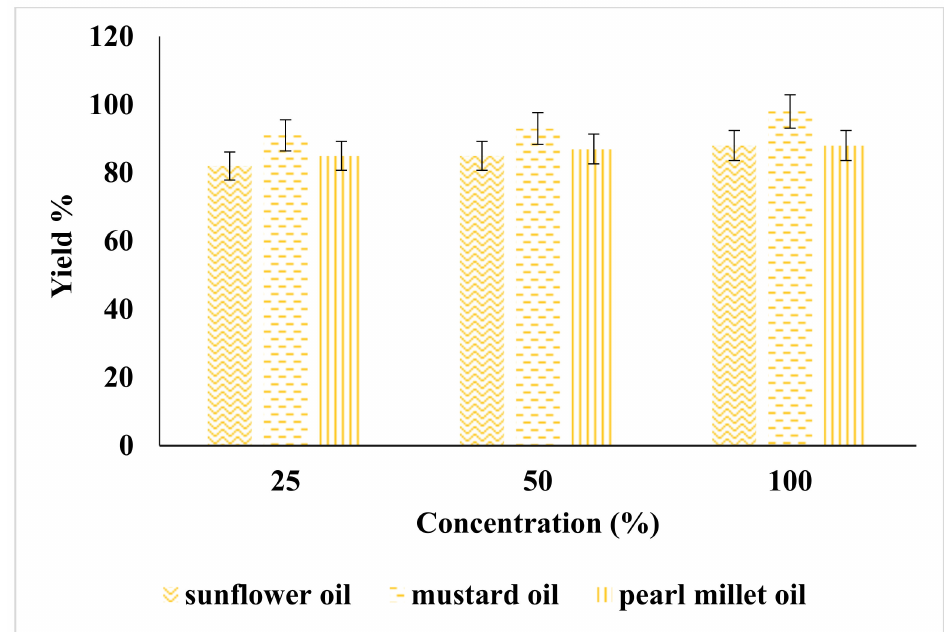
Figure 3. Percentage yield of biodiesel using HCl (wt.%) as acid catalyst.